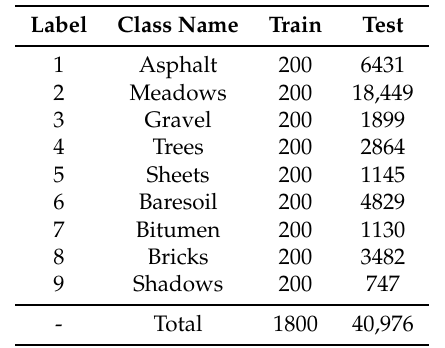
Table 2. The distribution of training and testing samples of the University of Pavia data set.